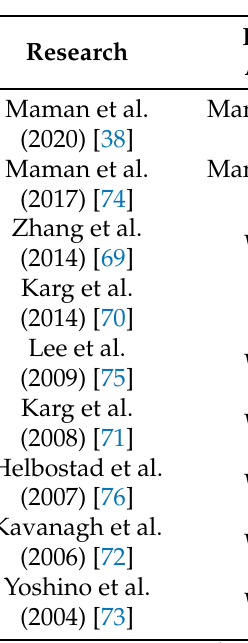
Table 1. A summary of fatigue modeling